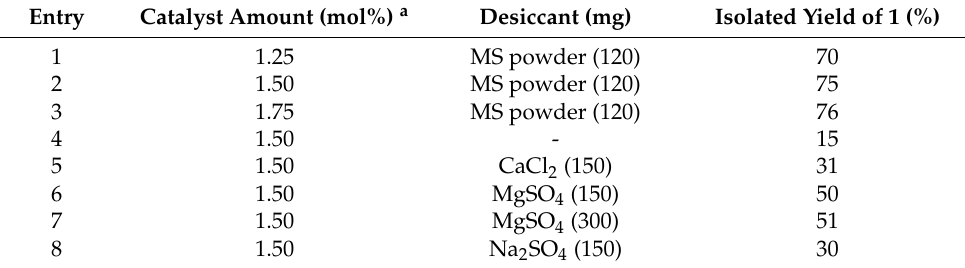
Table 3. Optimization of SSANa (3.0 mmol/g) amount.